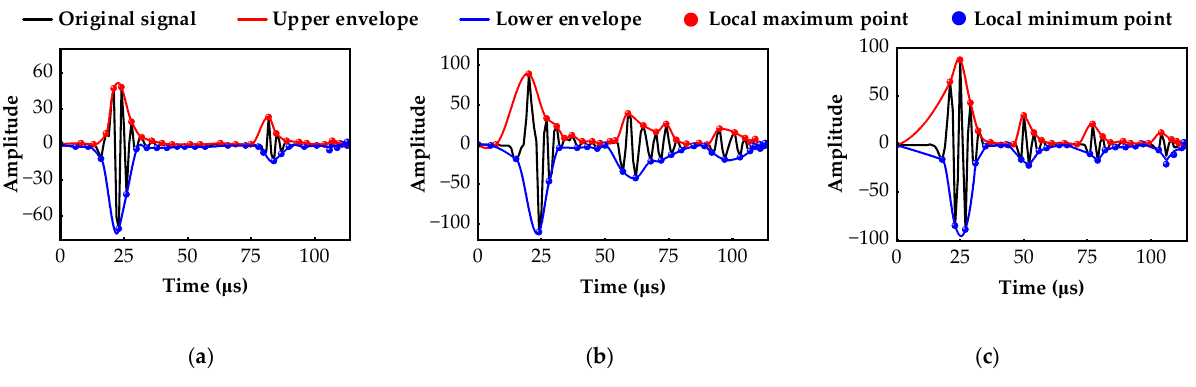
Figure 3. Results of envelope feature extraction. ( a ) two echoes signal. ( b ) three echoes signal. ( c ) four echoes signal. The black line in the figure indicates the original ultrasound signal. The red line indicates the upper envelope derived using the Akima-based data interpolation method proposed in this paper. The black line indicates the lower envelope derived using the Akima-based data interpolation method proposed in this paper. The red points indicate the local maxima points. The black points indicate the local minima points.